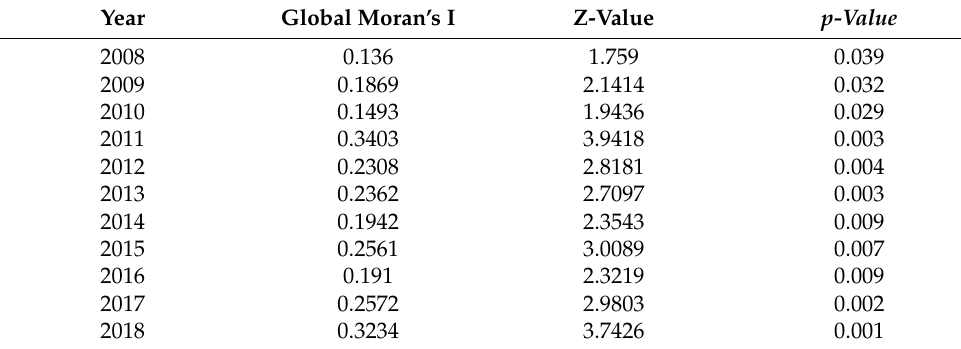
Table 2. Global Moran’s I of the CLUE in the study area from 2008 to 2018.